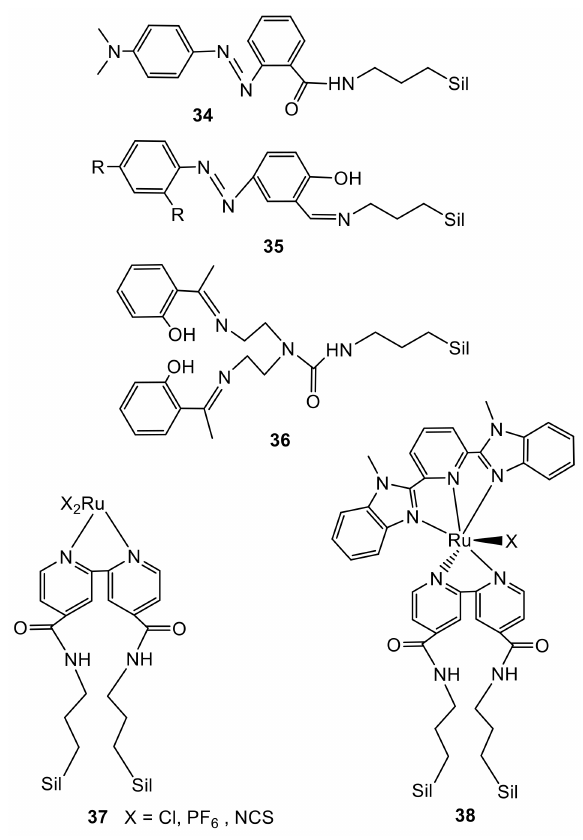
Figure 10. Chemical structures of silatranyl dyes ( 34 – 38